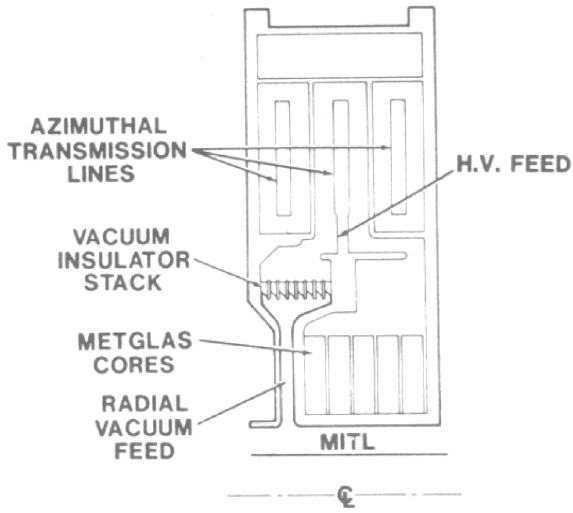
FIG. 35. Hermes-III cell schematic (from Ref. [52]).